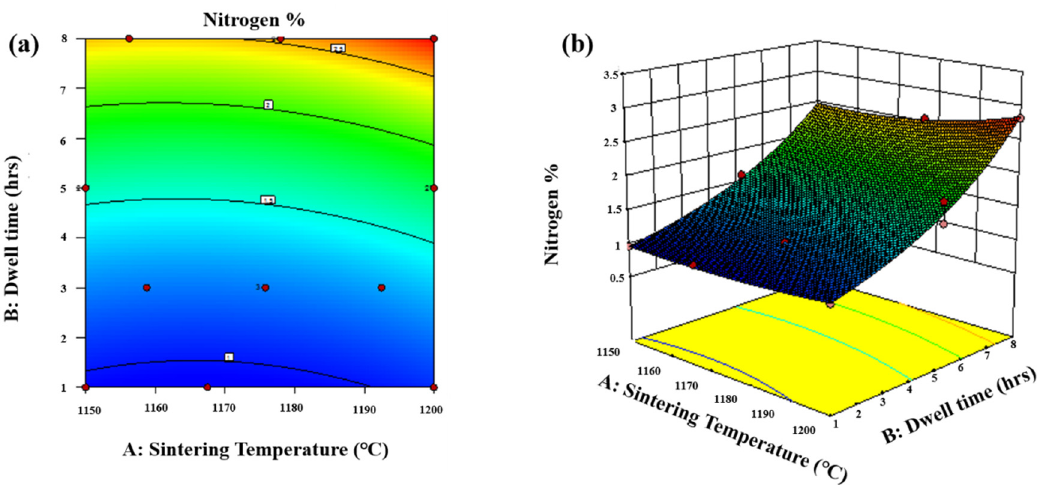
Figure 11. Contour and three-dimensional (3D) plots of nitrogen absorption.